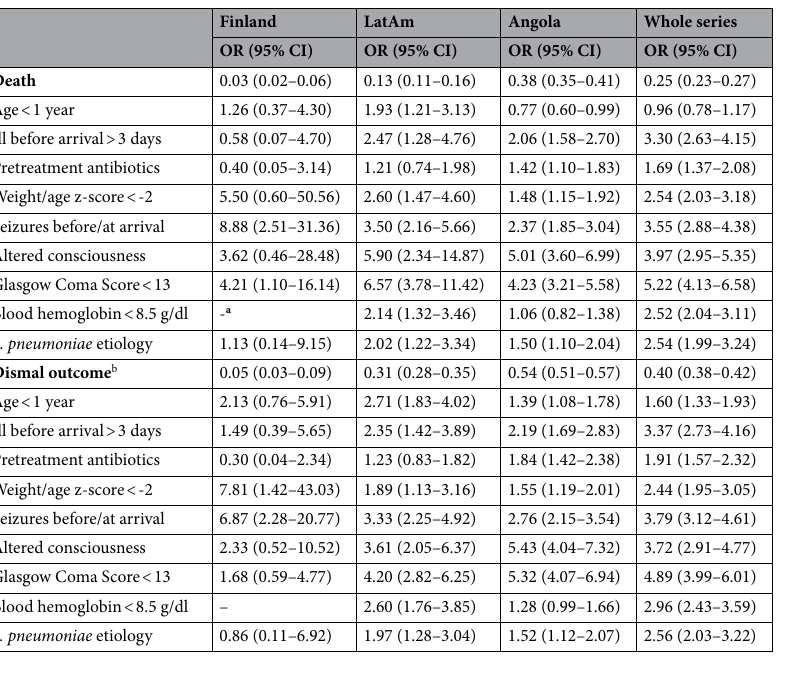
Table 2. Odds ratios with 95% confidence intervals of variables related to death or dismal outcome, univariate analysis. a No cases in Finland. b The triad of death, severe neurological sequelae, or